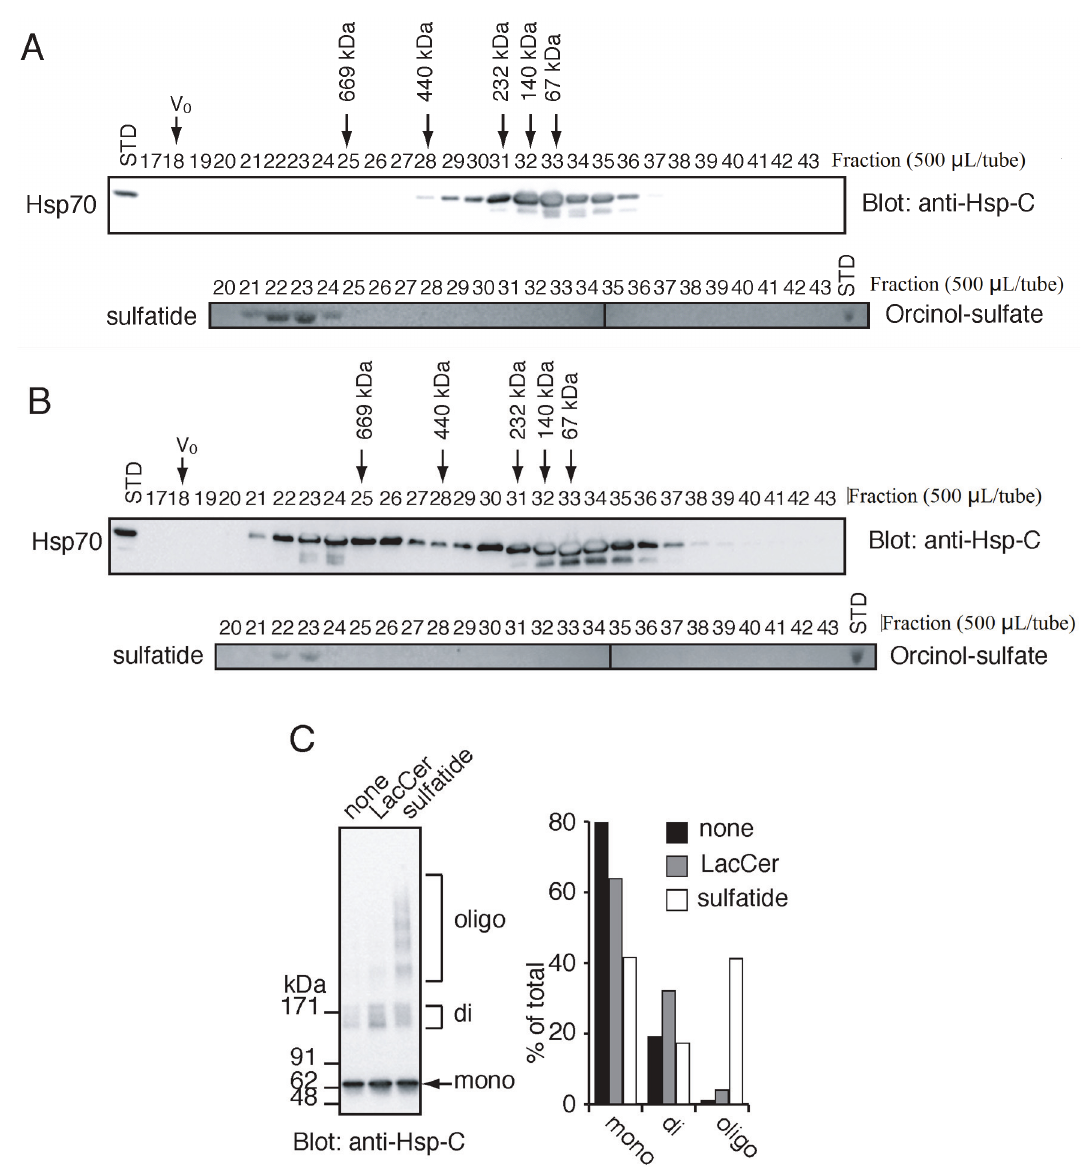
Figure 1. Sulfatide-Hsp70 interaction induces oligomerization of 70-kDa heat shock protein (Hsp70). ( A ) Hsp70 (top panel) and sulfatide (bottom panel) were separately analyzed by gel filtration chromatography. Fractions and external standards (STD; Hsp70, 35 ng; sulfatide, 2 (cid:2)g) were analyzed by Western blot using anti-Hsp-C antibody for Hsp70 or TLC/orcinol sulfate method for sulfatide. V 0 indicates void volume. Thyroglobulin (669 kDa), Ferritin (440 kDa), catalase (232 kDa), aldolase (140 kDa) and albumin (67 kDa) were used as molecular weight markers; ( B ) Hsp70 and sulfatide were co-incubated and analyzed as in A ; ( C ) Hsp70 was incubated with or without lactosylceramide (LacCer) and sulfatide and chemically cross-linked with glutaraldehyde. The products were separated by SDS-PAGE (stacking gel, 3% and separating gel, 3%–7%) and analyzed by Western blot using anti-Hsp-C antibody (left panel). Relative amounts of mono-, di-, and oligomers of Hsp70 were quantitated (right panel); ( D ) The Hsp70-sulfatide complex was analyzed by native-PAGE, followed by Western blot using anti-Hsp-C antibody. Monomer and dimer indicate the mono- and dimeric form of